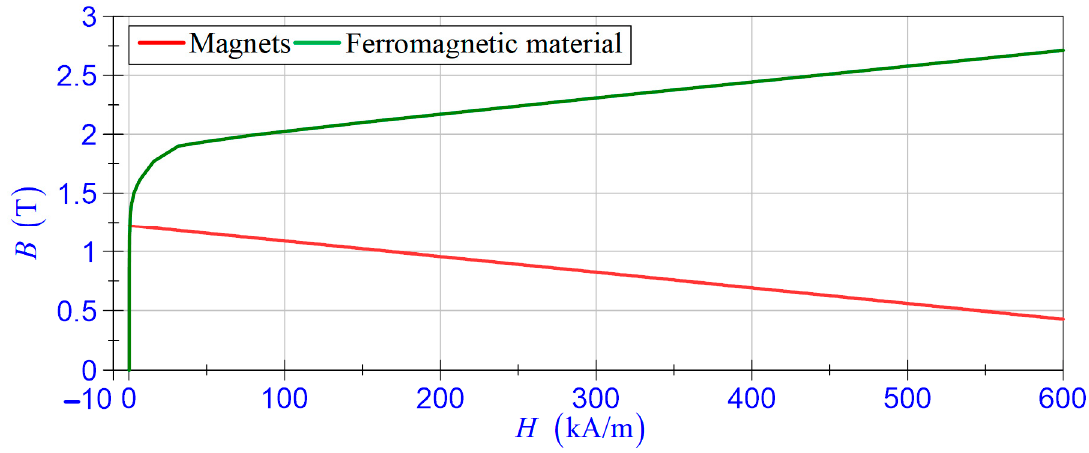
Figure 2. Magnetic characteristics of magnets and ferromagnetic material.